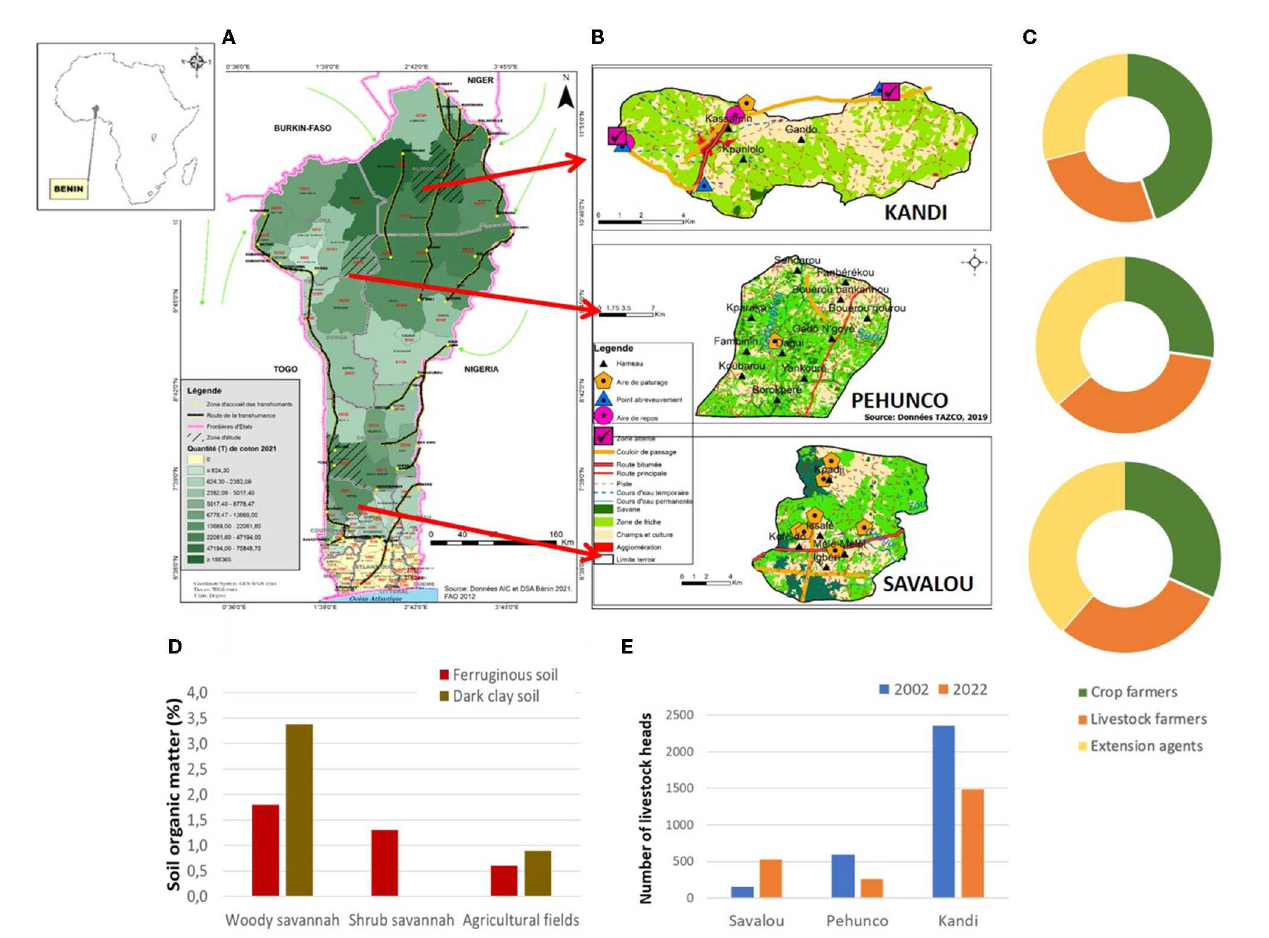
FIGURE1 (A) Map of Benin (and Africa) indicating the cotton growing zones, main transhumance routes and location of the three study areas. (B) Land use maps of each study area, indicating main transhumance routes. (C) Proportion of crop farmers, livestock farmers and extension agents participating in this study. (D) Soil organic matter decline in two main soil types used from cotton cultivation, from natural vegetation to agricultural fields adapted from: Igue et al. (2013). (E) Number of livestock herds per study zones from 2002 to 2022 years (2022